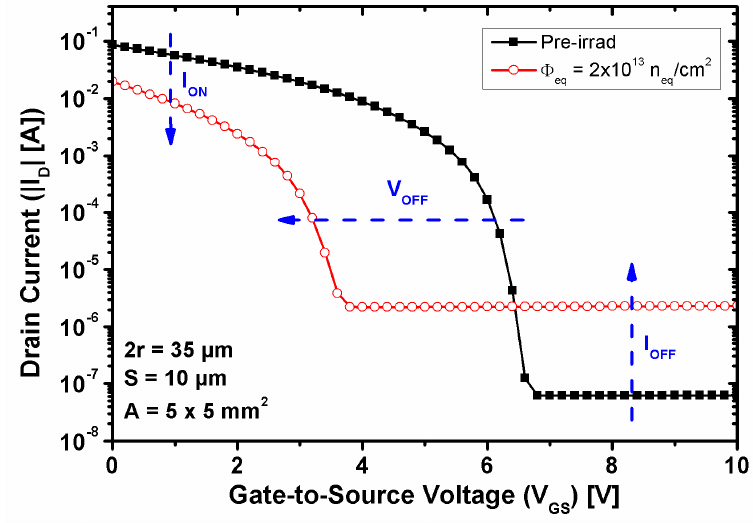
Figure 12 . Measured transfer characteristic curves for a V-JFET sample, before and after a neutron irradiation with equivalent fluence of 2 × 10 13 n eq /cm 2 . The effects on I ON , I OFF , and V OFF are indicated in the figure.